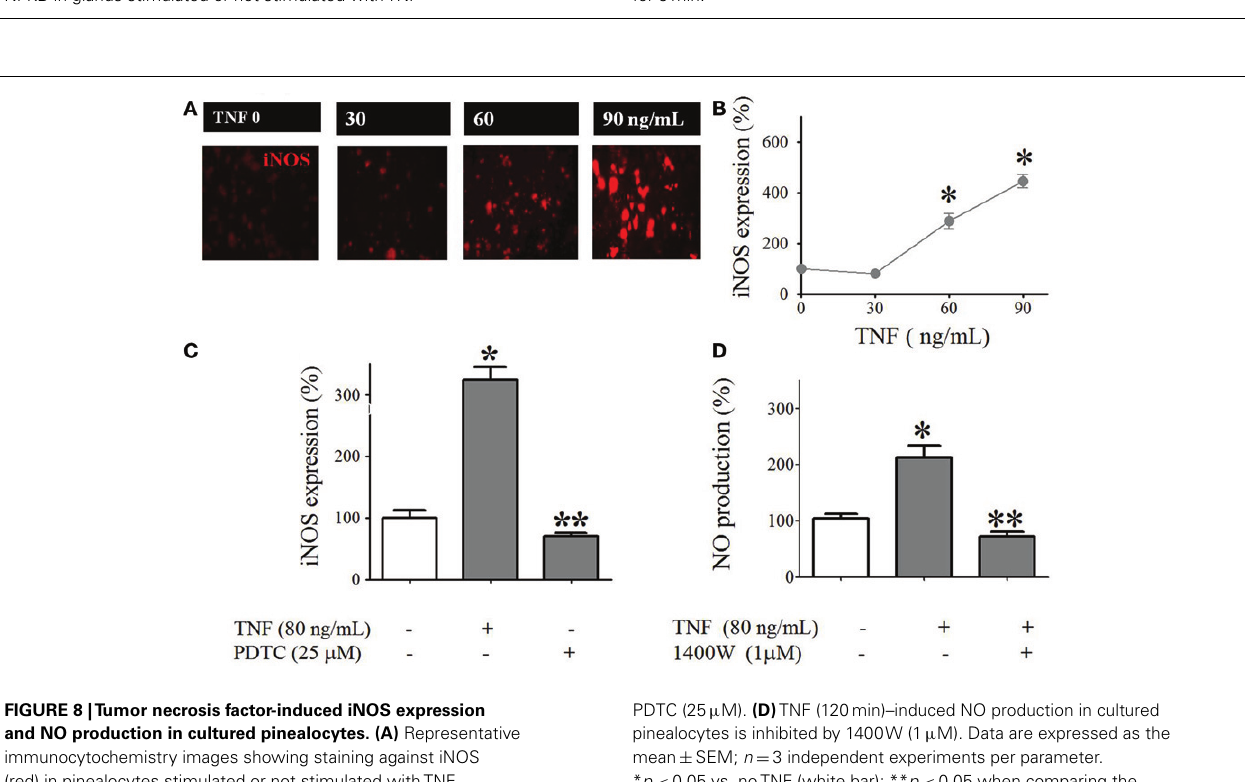
(10–90ng/mL) for 5min. (B) Representative gel of anti-p50-supershifted NFKB in glands stimulated or not stimulated withTNF